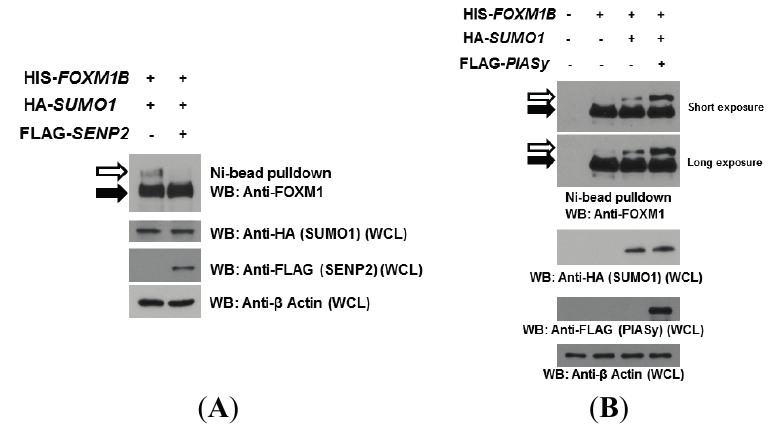
plasmids. Forty-eight hours later, cell lysates were subjected to Ni 2+ bead pulldown, followed by anti-FOXM1 immunoblotting. Whole cell lysates (WCL) were subjected to anti-HA, anti-FLAG, or anti- β Actin immunoblotting for SUMO1, SENP2, or β -Actin expression, respectively. The empty arrows indicate SUMOylated FOXM1B; The solid arrows indicate non-SUMOylated FOXM1B; ( B ) MCF7 cells were co-transfected HIS- FOXM1B and HA- SUMO1 with or without FLAG-tagged PIASy plasmids. Forty-eight hours later, cell lysates were subjected to Ni 2+ bead pulldown, followed by anti-FOXM1 immunoblotting. Whole cell lysates (WCL) were subjected to anti-HA, anti-FLAG, or anti- β Actin immunoblotting for SUMO1, PIASy, or β -Actin expression, respectively. The empty arrows indicate SUMOylated FOXM1B; The solid arrows indicate non-SUMOylated